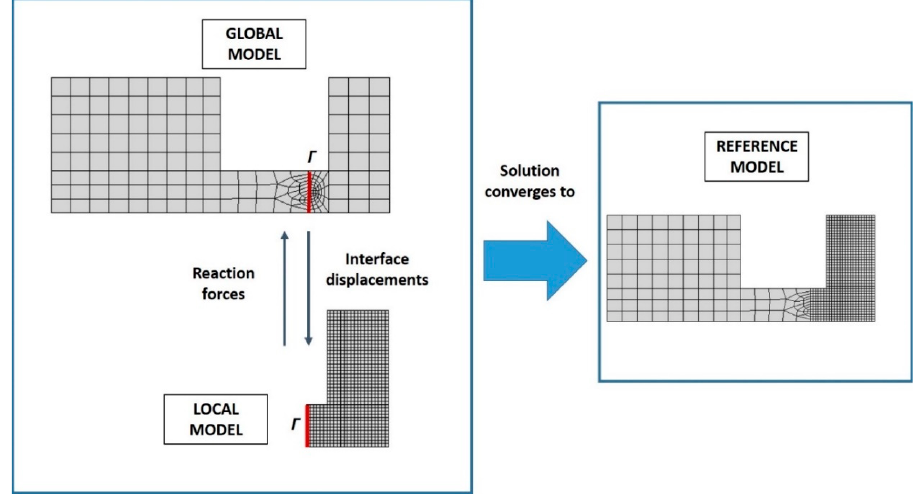
Figure 3. Global/Local submodelling approach. Figure 3. Global / Local submodelling approach.